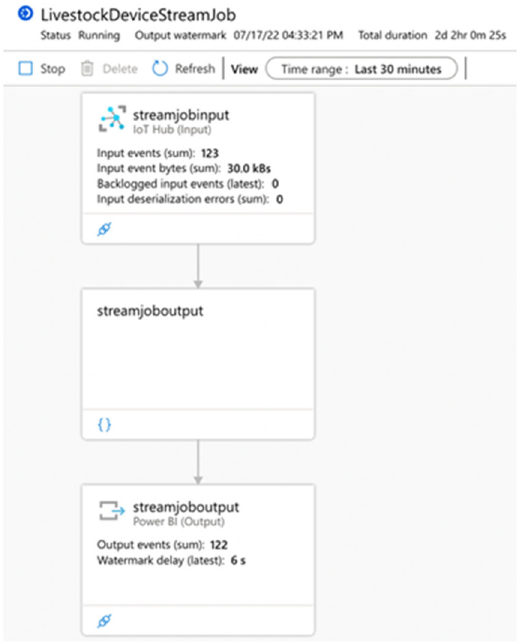
Figure 7. Data pipeline—IoT Hub (input), Stream Analytic Job (query), Power BI (output).